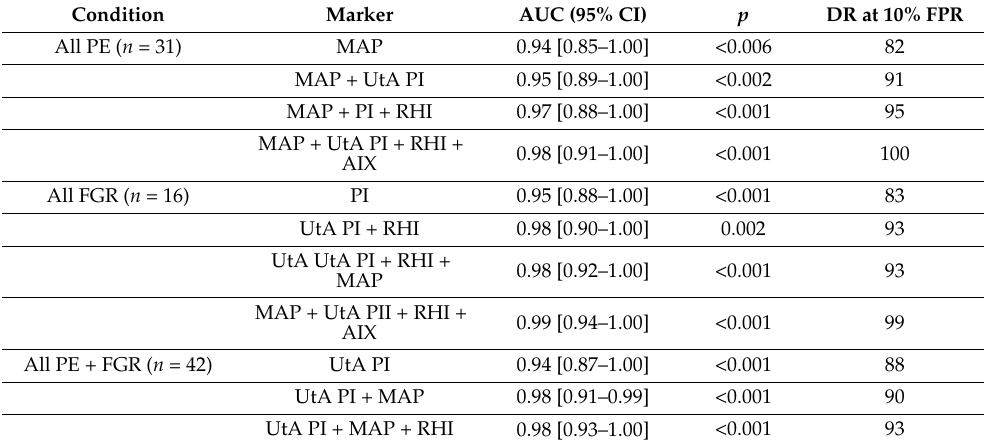
Table 4. Combined analyses of the biophysical